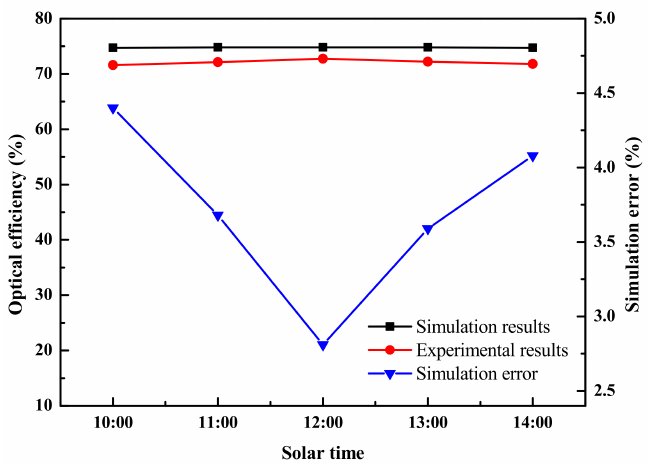
Figure 9. The optical efficiency and the simulation error for various apparent solar times.